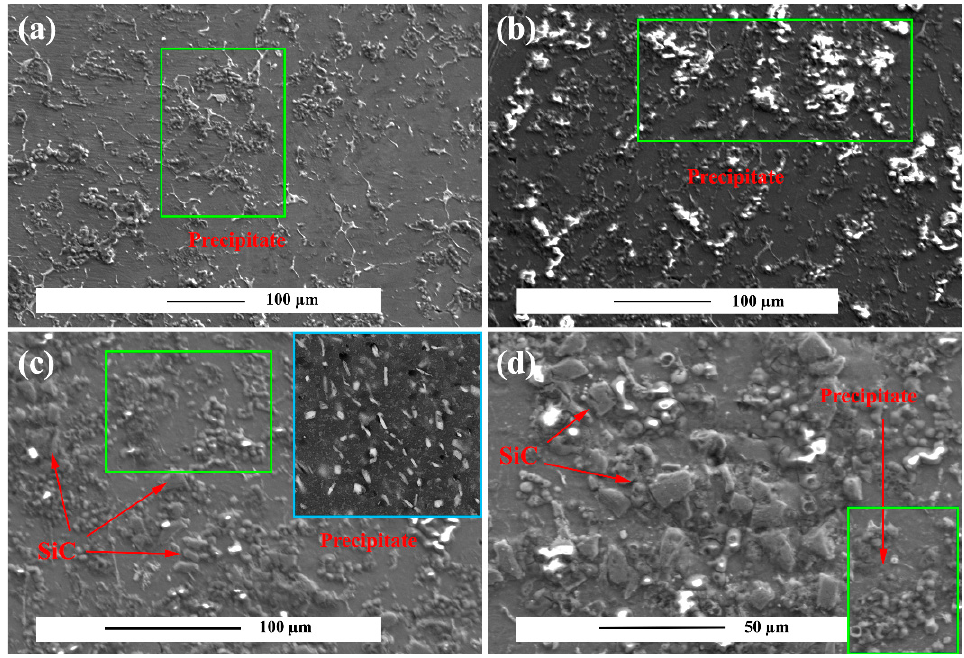
Figure 8. Scanning electron microscopic image of the microstructure after creep test at 150 °C under 100 MPa stress: ( a ) unreinforced alloy under 30 MPa, ( b ) unreinforced alloy under 100 MPa, ( c ) ZK60/SiCp composite under 100 MPa, and ( d ) ZK60/SiCp composite under 100 MPa.